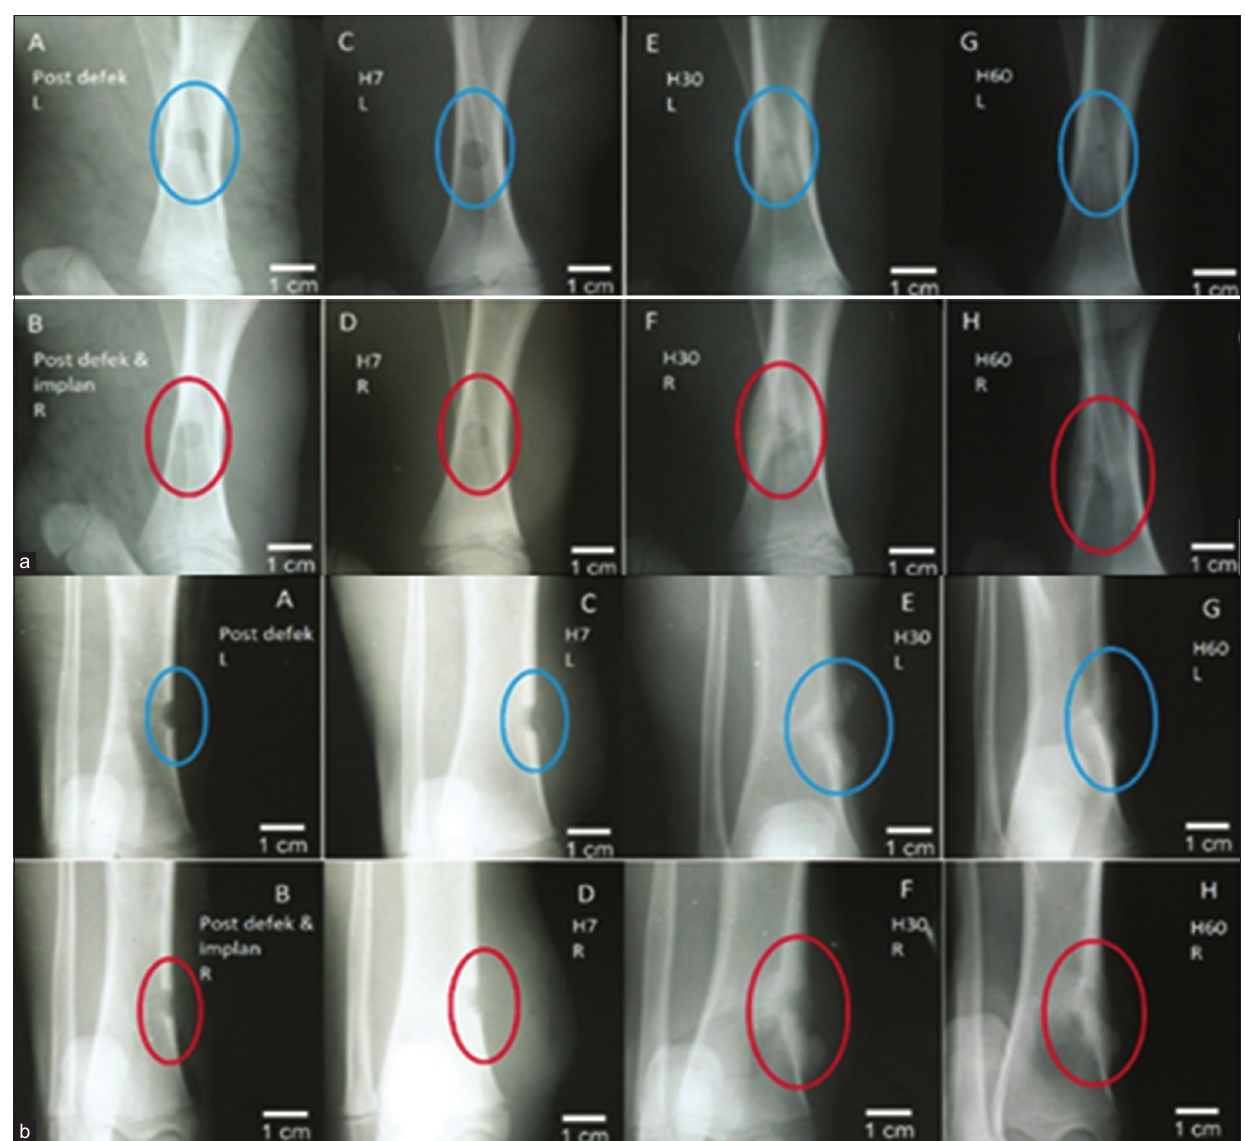
Figure-3: Radiographic images of the tibial bone (days-0, 7, 30, and 60) upper row-defect control, lower row-defect with implant. (a) Mediolateral image of tibial bone (b) craniocaudal image of tibial bone.